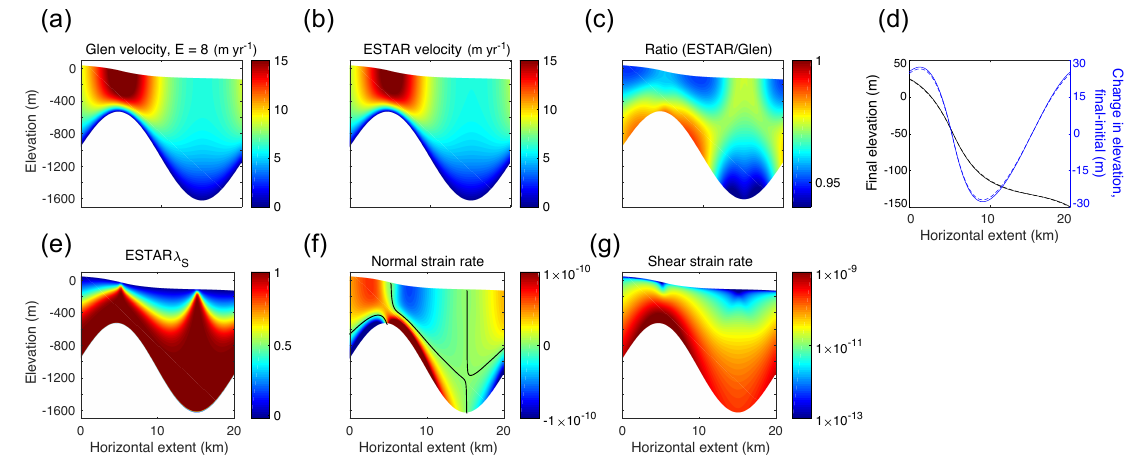
Figure 6. ISMIPBp full-Stokes steady-state results with horizontal extent L = 20km. (a) Horizontal velocity v x (myr − 1 ) for the Glen flow relation with E G = 8; (b) v x (myr − 1 ) for ESTAR with E S = 8 and E C = 3; and (c) ratio between the Glen and ESTAR v x fields; (d) steady- state surface elevation (black) and difference between steady state and initial surface elevation (blue) for ESTAR (solid) and Glen (dashed); (e) ESTAR shear enhancement factor λ S (Eq. 6); (f) ESTAR normal strain rate (i.e. x − x strain rate; s − 1 ); and (g) ESTAR shear strain rate (i.e. x − z strain rate; s − 1 ). The black contours in (f) correspond to the curves where ˙ (cid:15) xx = 0. Note the log scale in (g) .